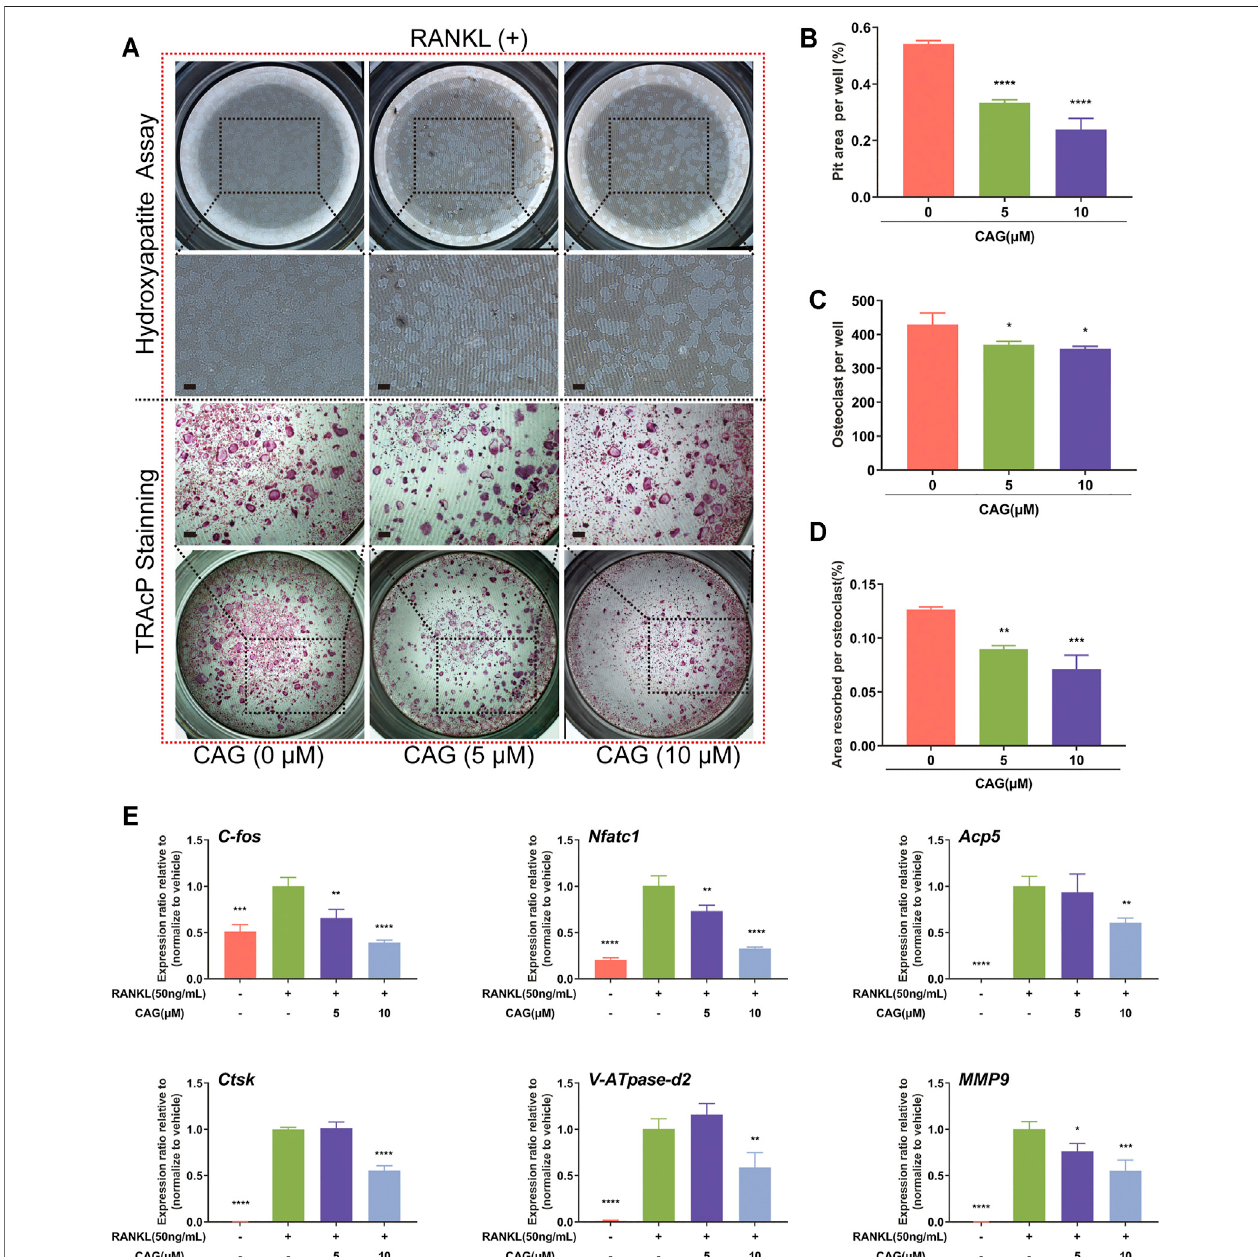
FIGURE 2 | CAG blocks bone resorption and osteoclast-speci fi c gene expression in RANKL stimulated BMMs. (A) Typical images of resorption pits and TRAcP staininginBMMstreatedwith5,10 µMofCAG for6days (B – D) Thequantitativecomparison showedthatthepitsareaper well,theosteoclasts number, andtheratioof the two (i.e., the pits area of a single osteoclast) decreased stepwise in BMMs treated with 5 and 10 µM CAG. (E) Quantitative comparison of real-time qPCR showed that osteoclast-speci fi c gene expression, including c-Fos , Acp5 , Nfatc1 , Atp6v0d2 , Ctsk , and Mmp9, declined stepwise in BMMs treated with 5 and 10 µM CAG. Data of all histograms are displayed as mean (SD). n (cid:1) 3. * p < 0.05, ** p < 0.01, *** p < 0.001. **** p < 0.0001. Scale bar (cid:1) 200 µM. RANKL: receptor activator of nuclear factor κ Bligand;CAG:cycloastragenol; TRAcP:tartrate-resistantacidphosphatase; c-Fos :proto-oncogenec-Fos; Acp5 :acidphosphatase5; Nfatc1